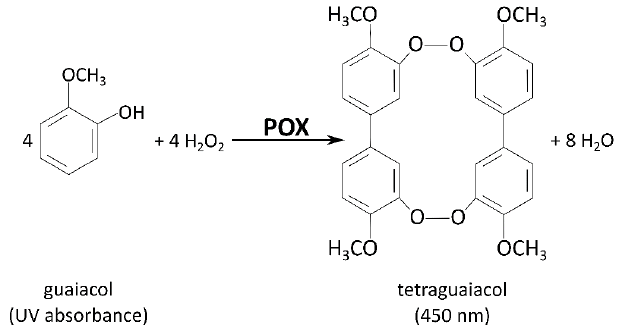
Figure 3. Reaction scheme for the photometric peroxidase (POX) and cell wall-bound peroxidase (cwPOX) activity assay. The aromatic oil guaiacol is used by POX/cwPOX as an electron donor for the reduction of H 2 O 2 . Guaiacol (colorless) is oxidized into tetraguaiacol, which can be detected by an increase in absorbance at 420 – 470 nm [47]. Figure modified from Lopes et al.